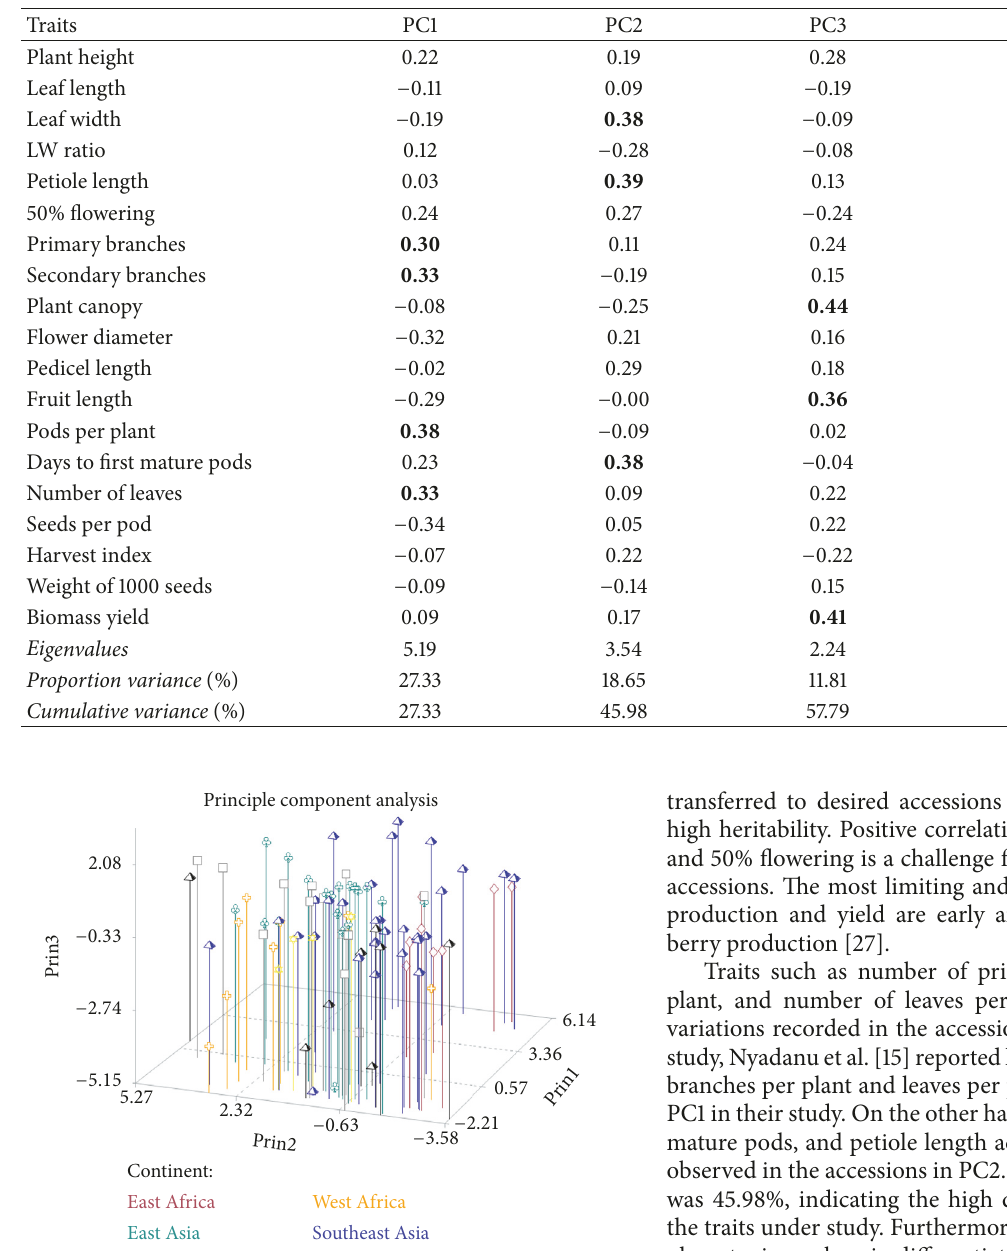
Table 6: Eigenvalues, proportion of variance, and morphological traits that contributed to the first five PCs.